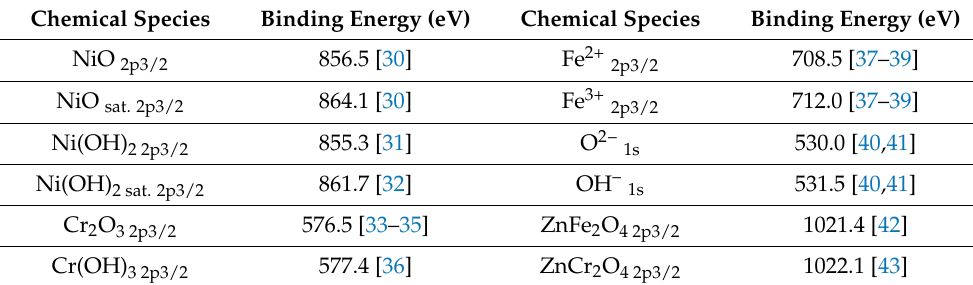
Table 3. Binding energies of chemical species for XPS